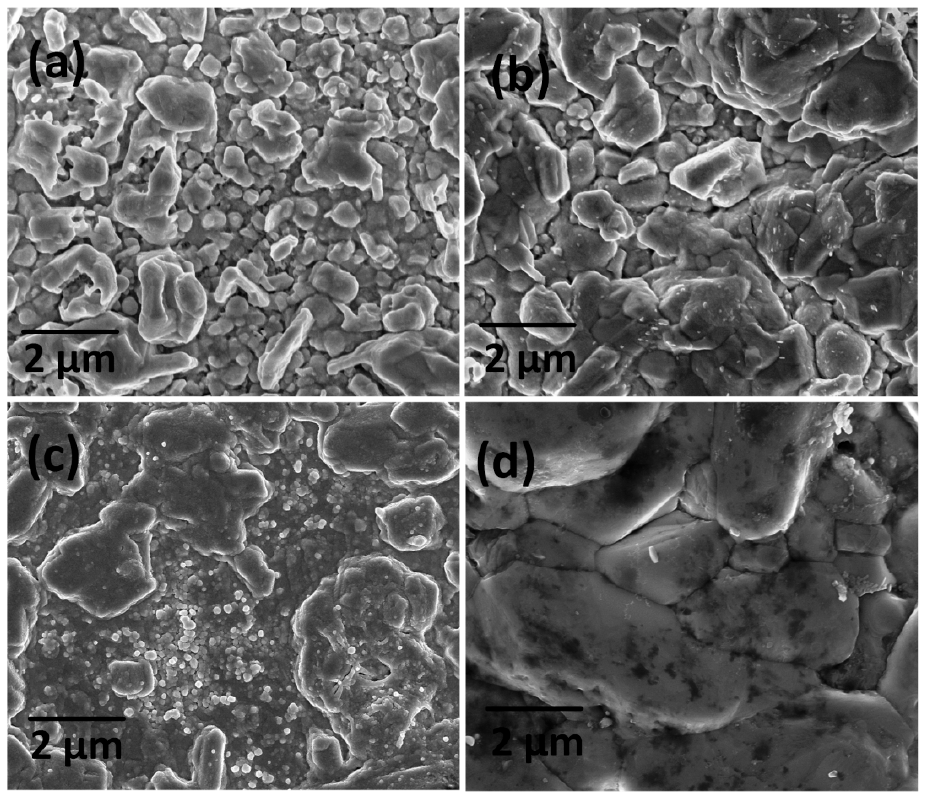
Figure 4. Field emission scanning electron micrographs of the Cu 2 ZnSnS 4 (CZTS) layer surfaces pre- pared using 1,8-diiodooctane (DIO) additive concentrations of ( a ) 5, ( b ) 10, ( c ) 15, and ( d ) 20 mg/mL.